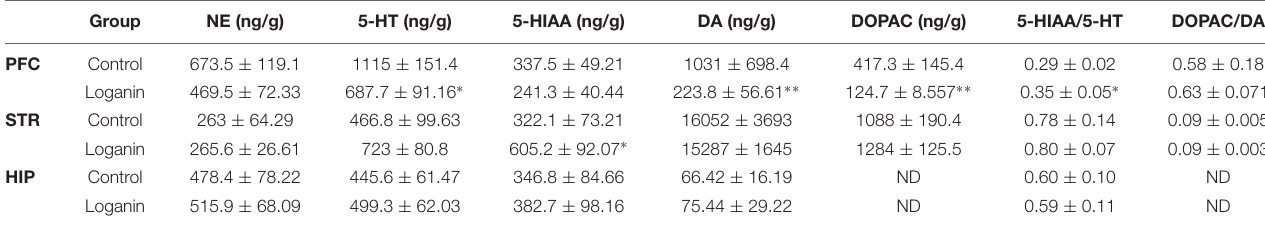
FIGURE 8 | Effect of loganin on the sleep architecture in freely moving rats. EEG and EMG recordings were immediately applied 6 h after intragastric administration of loganin (35 mg/kg, i.g.) or vehicle. Total sleep and sleep latency (A) , percentage of wakefulness, REM sleep and NREM sleep (B) , percentage of power density (C) and percentage of delta (0.5–4 Hz), theta (4–8 Hz), alpha (8–13 Hz) and beta bands (13–30 Hz) of NREM sleep (D) were examined. Data are presented as mean ± SEM ( n = 4–5). ∗ P < 0.05, ∗∗ P < 0.01, vs. vehicle (One-way ANOVA followed by Least Significant Difference). TABLE 3 | The concentrations of NE, 5-HT, DA, and their metabolites in the hippocampus, prefrontal cortex and striatum after loganin